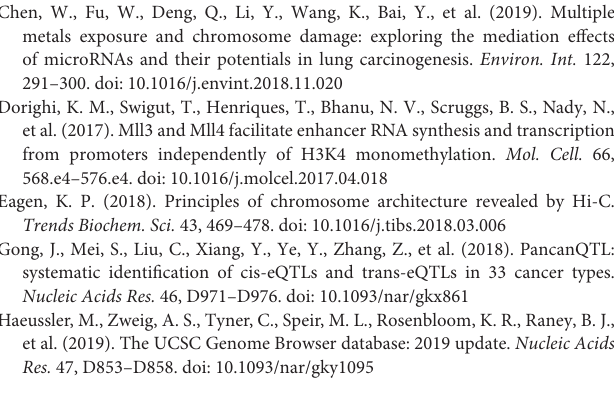
for PAAD, the signal of enhancer in cancer tissue was higher than that of enhancer in normal tissue in most diseases. FIGURE S10 | The signal of H3K9me3 within ± 1 kb of the enhancer center in distal regulation pairs. The signal of H3K9me3 showed lower enrichment in miRes of distal regulation pairs compared with in non-miRes in most tumor tissues. There was no significant difference in normal tissues. FIGURE S11 | The signal of H3K9me3 within ± 1 kb of the enhancer center in proximal regulation pairs. The signal of H3K9me3 showed lower enrichment in miRes of proximal regulation pairs compared with in non-miRes in most tumor tissues. There was no significant difference in normal tissues. FIGURE S12 | The signal of H3K36me3 within ± 1 kb of the enhancer center in distal regulation pairs. The signal of H3K36me3 showed higher enrichment in miRes of distal regulation pairs compared with in non-miRes in most tumor tissues. There was no significant difference in normal tissues. FIGURE S13 | The signal of H3K36me3 within ± 1 kb of the enhancer center in proximal regulation pairs. The signal of H3k36me3 had no significant difference in the miRe of distal regulation pairs in most tumor and normal tissues compared with that of non-miRe. FIGURE S14 | Expression of three genotypes of rs6603785. Significant differences in the expression levels of the three genotypes of this SNP (rs6603785).